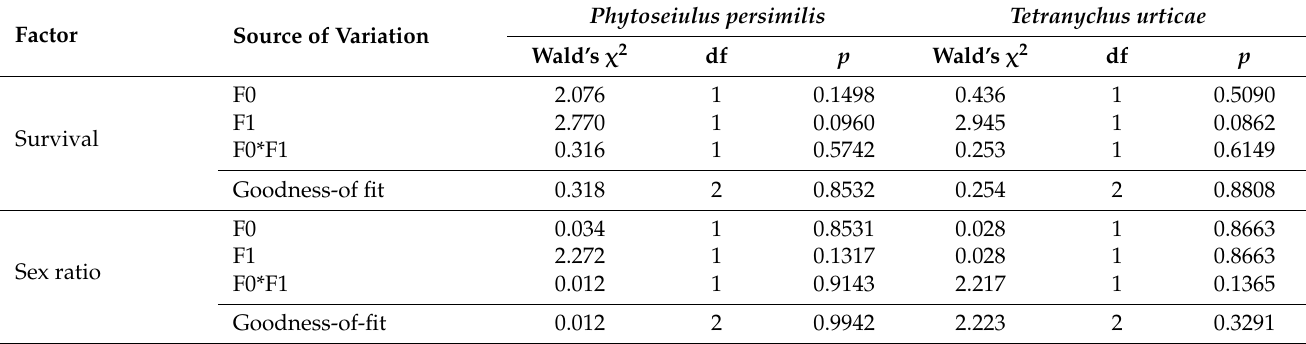
Table 1. Heat wave effects (mild or extreme heat waves) on juvenile survival and offspring sex ratio rates of offspring (F1) originating from parents (F0) reared under either mild or extreme heat wave conditions. Data were analyzed by means of logistic regression (PROC LOGISTIC in SAS). The Hosmer-Lemeshow test was used to assess the goodness-of-fit of the logistic model using F0 and F1 as predictor variables. Large p -values signify that the agreement between observed and predicted values was